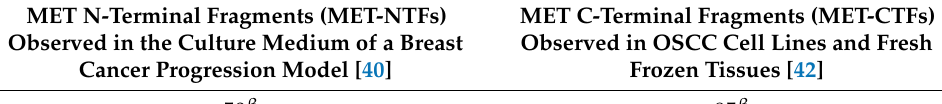
Table 1. Corresponding soluble N-terminal and presumed membranous C-terminal MET fragments resulting after ectodomain shedding named after their approximate molecular masses observed under reducing conditions